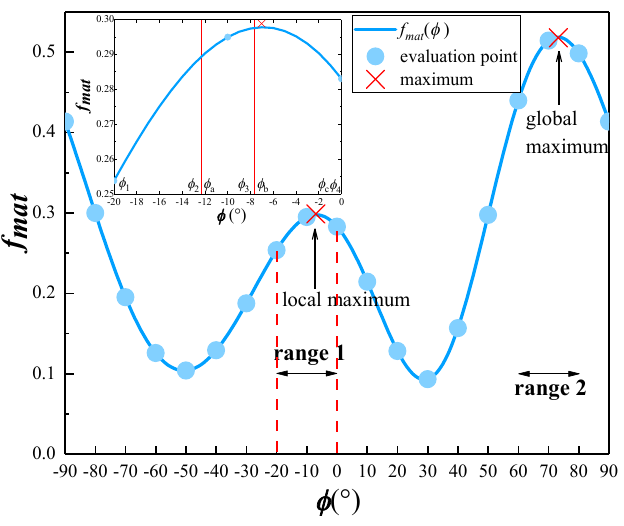
Figure 6. f mat versus ϕ in the interval [−90°, 90°].